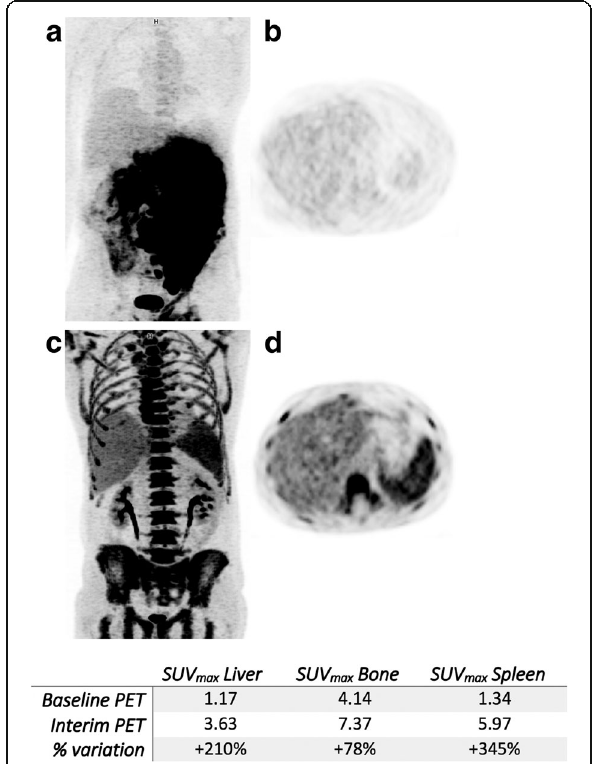
Fig. 2 Fifty-two-year-old male patients imaged at baseline ( a , b ) and after 4 cycles of R-ACVBP ( c , d ). Interim PET/CT was performed 7 days and 6 days following the last injection of chemotherapy and G-CSF, respectively. The injected G-CSF was lenograstim, at a dosage of 34MUI daily for a 4-day period. In this case, low hepatic 18 F-FDG uptake can be observed at baseline because of a tracer sequestration in the bulky mass. This pattern resolves after the tumour had shrunk on interim PET/CT, but because of a short time- lapse between the last chemotherapy injection and interim PET/CT, an increased bone marrow and splenic uptakes are observed